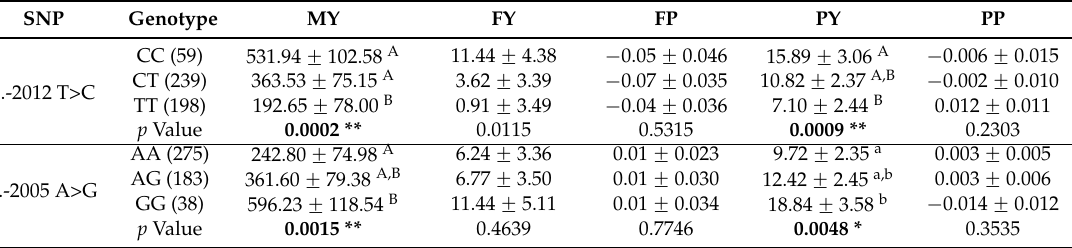
Table 3. Associations of SNPs with EBVs for five milk production traits (least squares mean ˘ standard error).